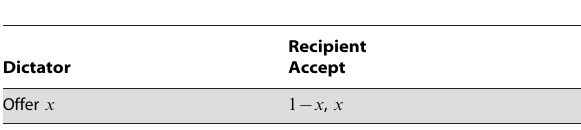
Table 1. The Dictator